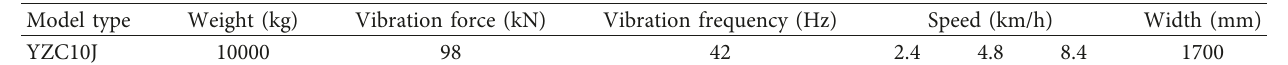
Table 5: The working parameters of YZC10J roller.